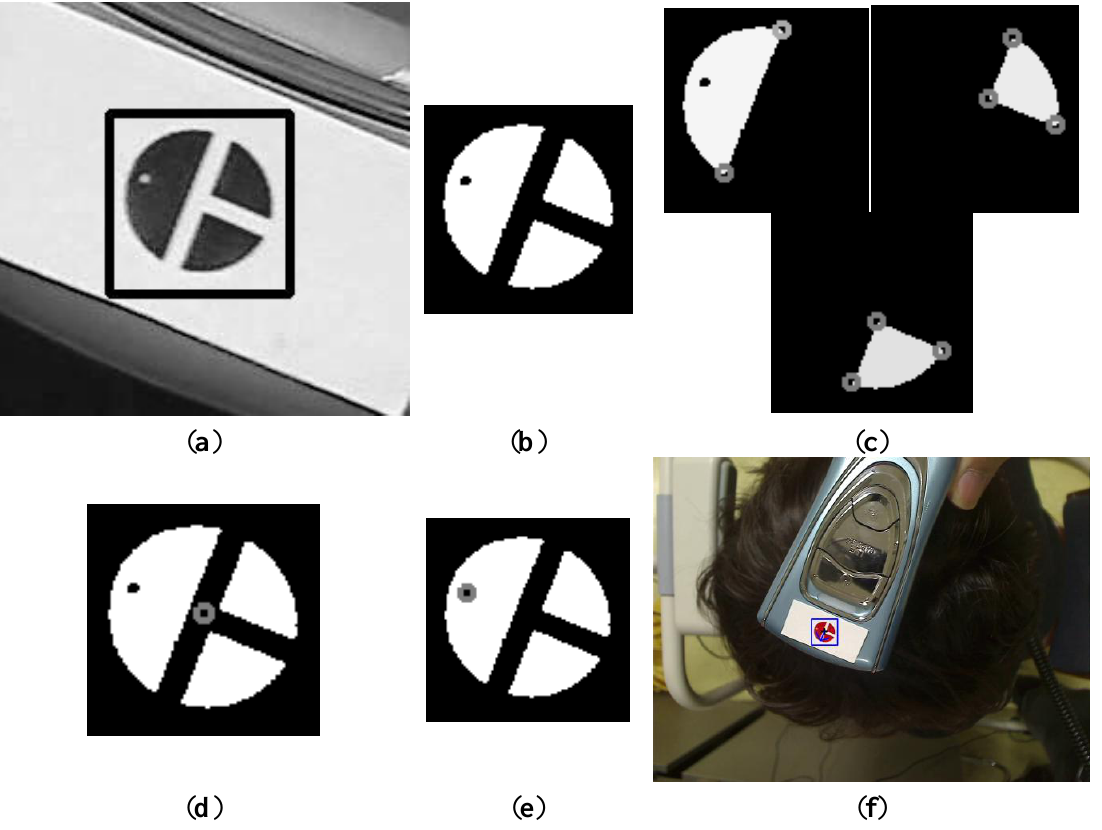
Figure 9. Detection of center and direction of the marker. ( a ) Obtained Y image based on marker position detected by sub-block difference-based matching; ( b ) Result of binarization and component labeling of the Y image; ( c ) Detection of the eight corner positions; ( d ) Detection of center of marker; ( e ) Detection of white point in the semi-circular area; ( f ) Results of detecting the direction and center of the marker.